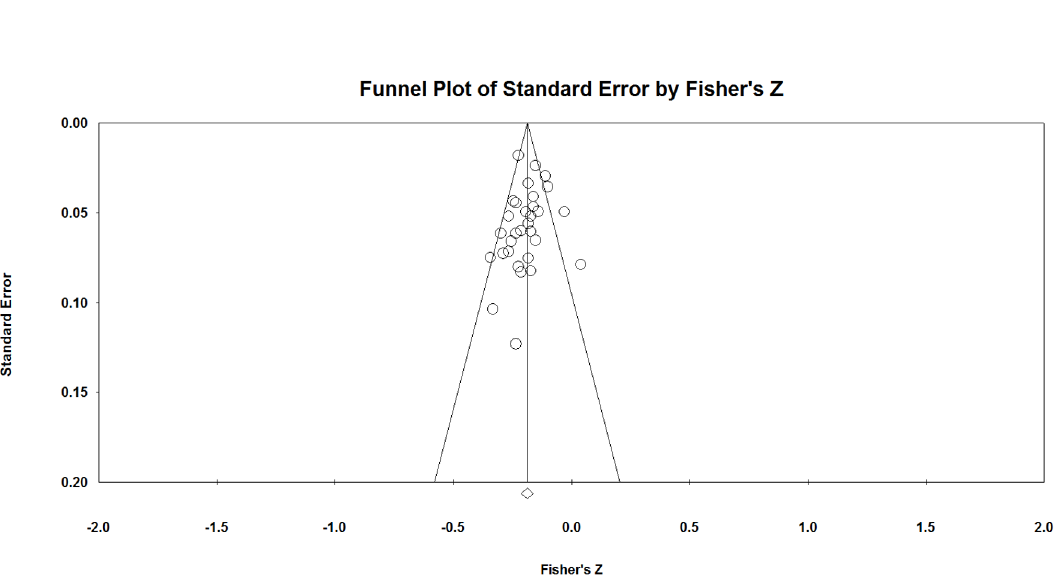
Fig 4. Funnel plot of standard error by Fisher’s